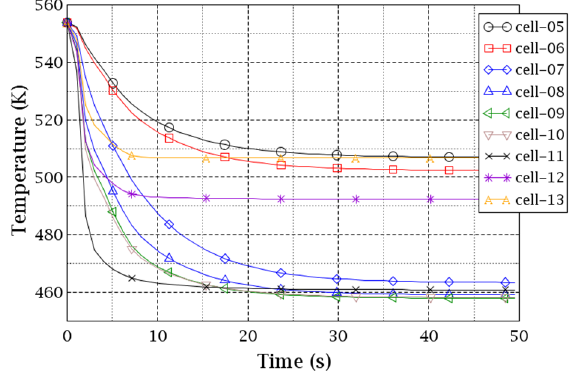
Figure 23. Evolution of the coolant temperature distribution at the core inlet of the AP1000 reactor CA-V cold-part (cell index is from Figure 21).